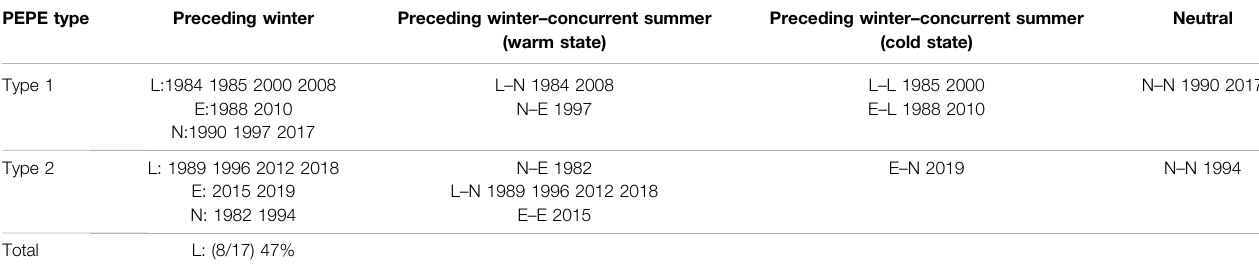
TABLE2| E,L,andNdenotetheSSTstatesofcentralandeasternequatorialPaci fi cisElNiño,LaNiña,andneutral,respectively.E – LmeanstheSSTstatestransitingfromEl Niño to La Niña from preceding winter (December – February, DJF) to concurrent summer (June – August, JJA), and vice versa. Red, blue, and black fonts mean SST of central and eastern equatorial Paci fi c in warm, cold, and neutral state,